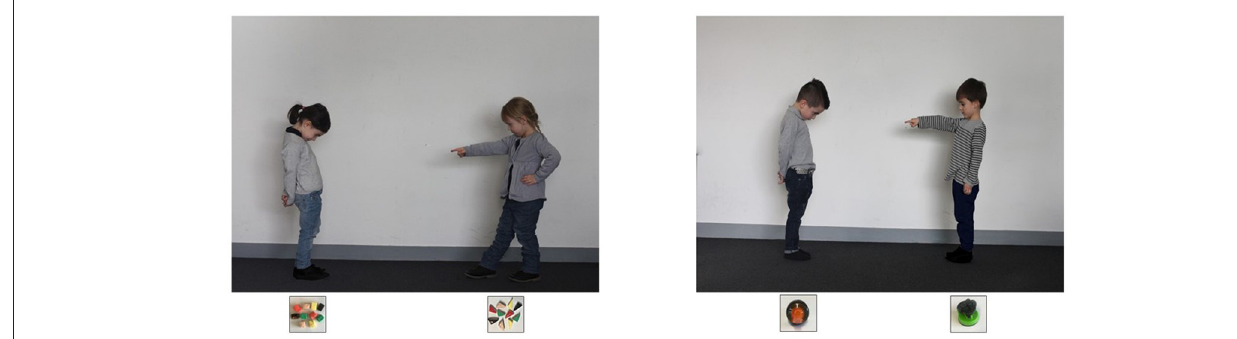
FIGURE 1 | Examples of stimuli with female and male characters in Experiment 1.